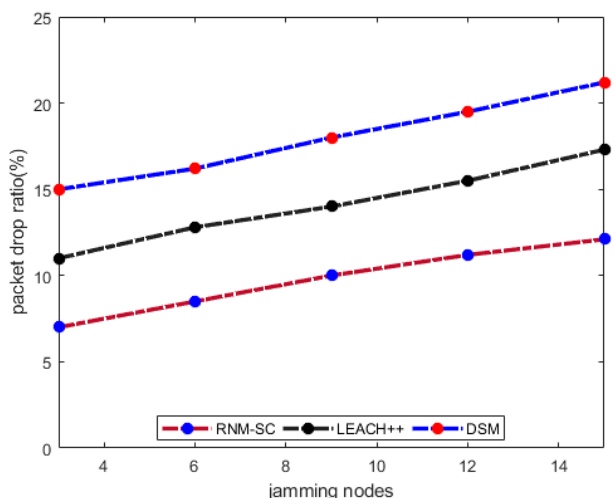
Figure 5. Packet drop ratio and jamming nodes.